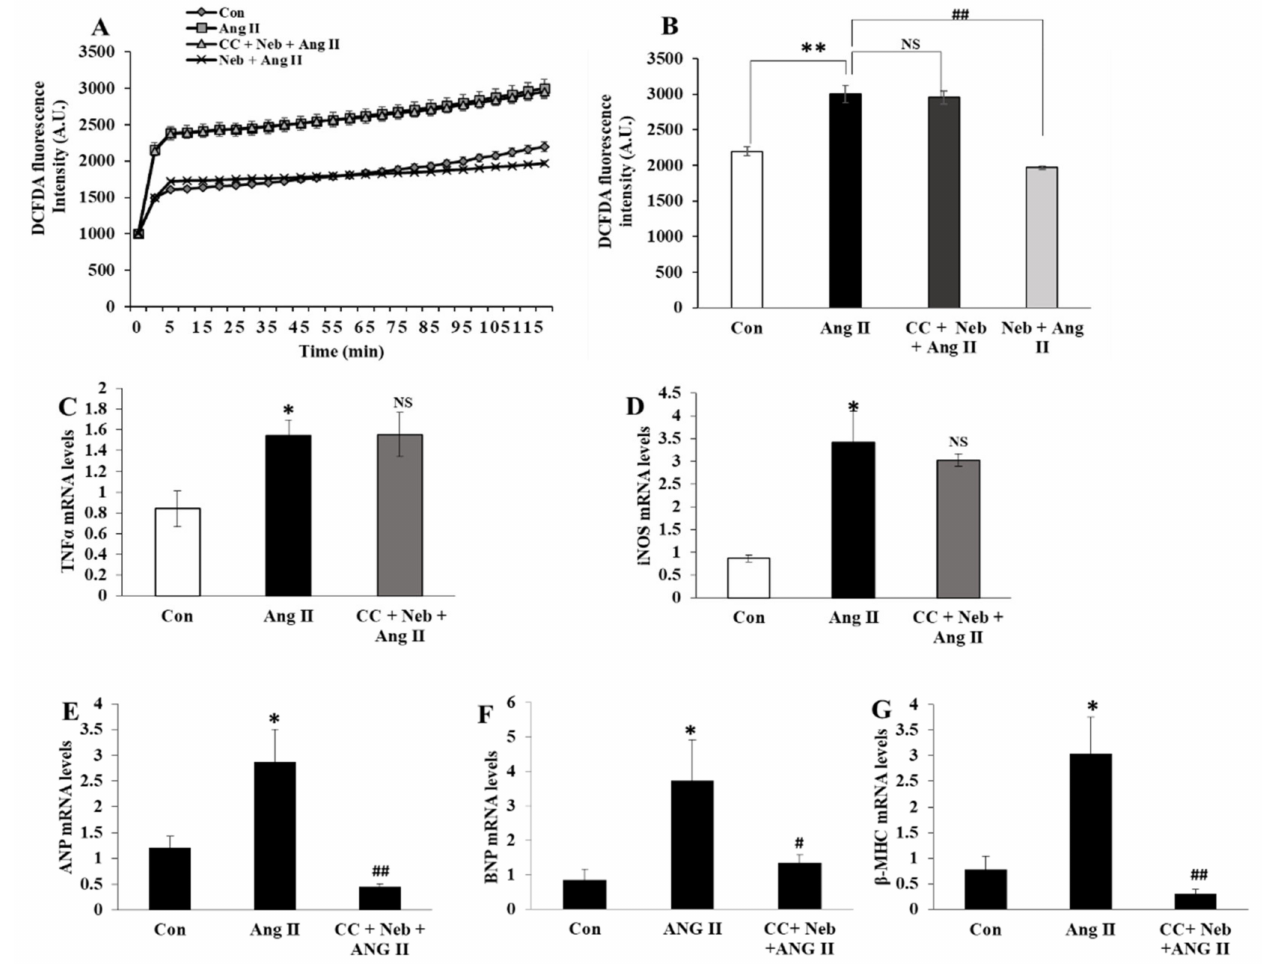
Figure 5. Effects of Neb plus compound C (CC) on Ang II-induced ROS generation and mRNA expressions of hypertrophy and inflammatory genes. Ang II-induced increase in DCFDA fluorescence was not affected by pretreatment with CC (5 µ M) plus Neb (1 µ M) but was significantly reduced by Neb alone ( A , B ) Ang II-mediated mRNA expression levels of proinflammatory cytokines TNF- α ( C ) and iNOS ( D ) were not reduced by CC plus Neb pretreatment. Ang II-mediated mRNA expressions of hypertrophy markers ANP ( E ), BNP ( F ), and β -MHC ( G ) were significantly reduced by CC plus Neb pretreatment. ** p < 0.02, * p < 0.05 vs. untreated (Con). ## p < 0.02, # p < 0.05 vs. Ang II and NS, nonsignificant vs. Ang II. Values are means ± SEM N ≥ 6 for each treatment